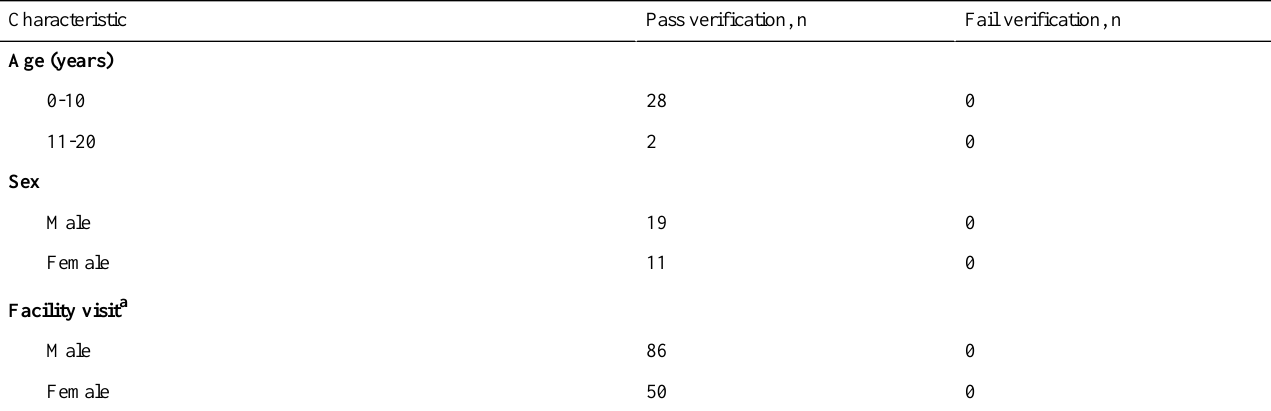
Table 1. Number of outpatient verification trial results.